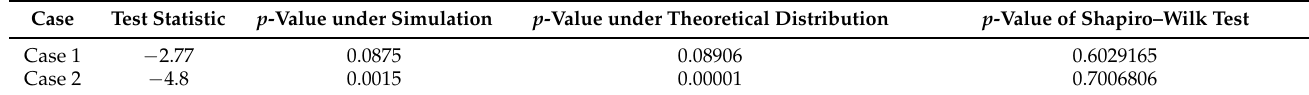
Figure 7. Histogram of the 4000 MID values obtained under simulation, and the MID contrast statistic calculated on the real positivity functional data in dashed line and the critical values in dotted lines for case 1 ( left panel ) and case 2 ( right panel ). Table 1. Summary of our test results in both